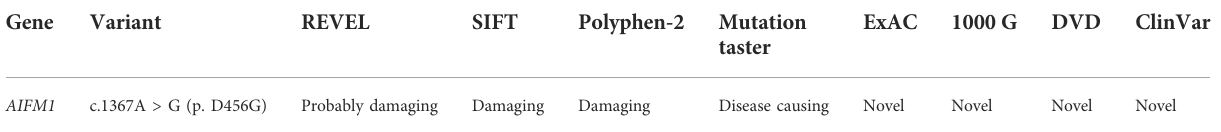
TABLE1 Characteristics of AIFM1 variant, analysis of predicted protein structure and disease-causing effects based on various databases. Gene